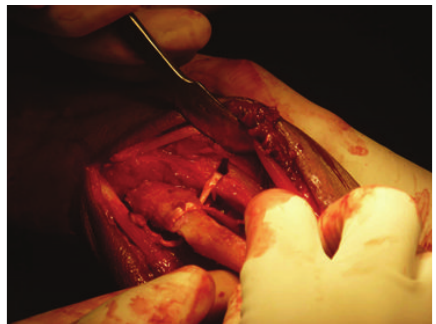
Figure 9: Resected specimen.